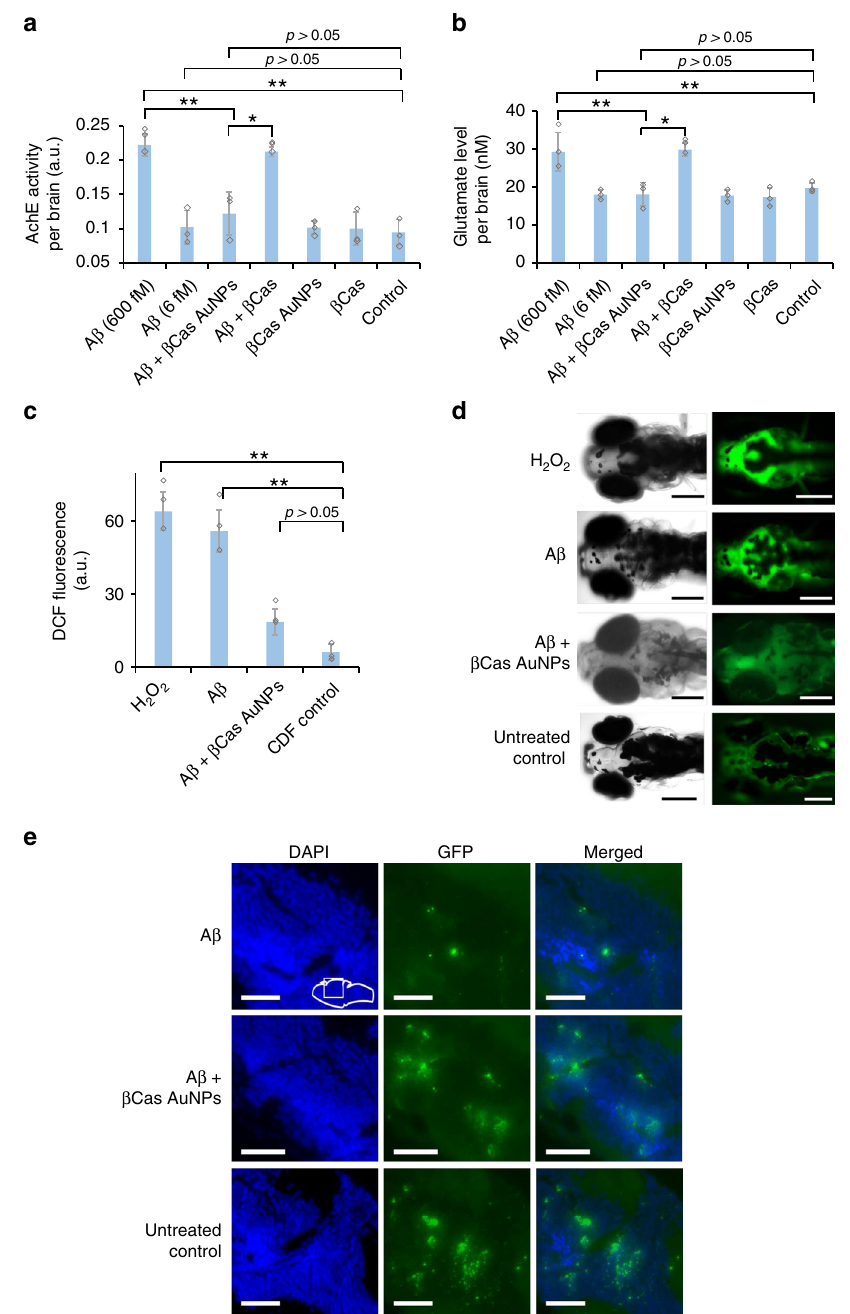
Fig. 6 Neurotransmitters and reactive oxygen species (ROS) in the brain of A β treated larvae. The biomarkers were measured 5 days post A β treatment. Cerebrovascular injection of A β peptide at 6 fM per larvae did not signi fi cantly ( p > 0.05) in fl uence the AchE ( a ) and GLT ( b ) levels in zebra fi sh larvae ( n = 10). However, increasing the A β dose to 600 fM signi fi cantly increased ( p < 0.05) AchE and GLT levels. β Cas AuNPs (3 ng Au per 4.5 ng β Cas), injected 2 h post A β treatment, signi fi cantly ( p < 0.005) reduced the AchE and GLT levels on the 5th day post A β (600 fM) treatment. β Cas micelles (dose equivalent to β Cas in 3 ng β Cas AuNPs), in comparison, failed to improve ( p > 0.05) the biomarker levels. c ROS generation was signi fi cantly ( p < 0.005) high in A β treated (600 fM) larvae. ROS generation was supressed in β Cas AuNPs treated larvae and close to control ( n = 10). d Representative images of zebra fi sh larvae expressing DCF/ROS fl uorescence when treated with H 2 O 2 , A β , A β + β Cas AuNPs, and A β + β Cas. e Larvae ’ s brain sections were stained for synaptophysin. A β -treated larvae presented loss of synaptophysin indicating neurodegeneration. Scale bars in all images are 200 µ M. Error bars represent the standard deviation. Source data are provided as a Source Data fi larvae were 41 ± 7.9 and 42.9 ± 8.7, respectively. However, upon treatment with β Cas AuNPs, the CT fl uorescence was reduced to 14.5 ± 5.4, comparable to DCF as negative control (8 ± 3.4). Synaptophysin-based neurodegeneration, an indicator for neuro- nal synapsis, was also imaged via immunostaining (Fig. 6e). A β